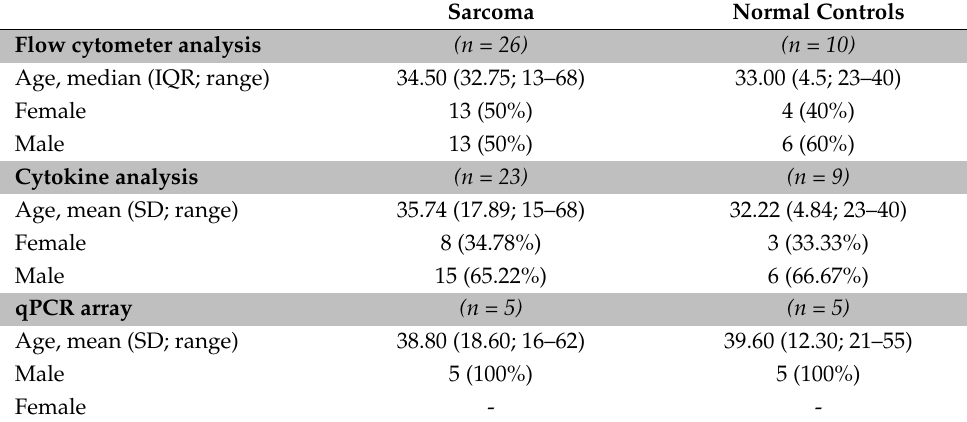
Figure 1. Flow chart of the research process. Table 1. Demographic profile of sarcoma patients and normal controls.